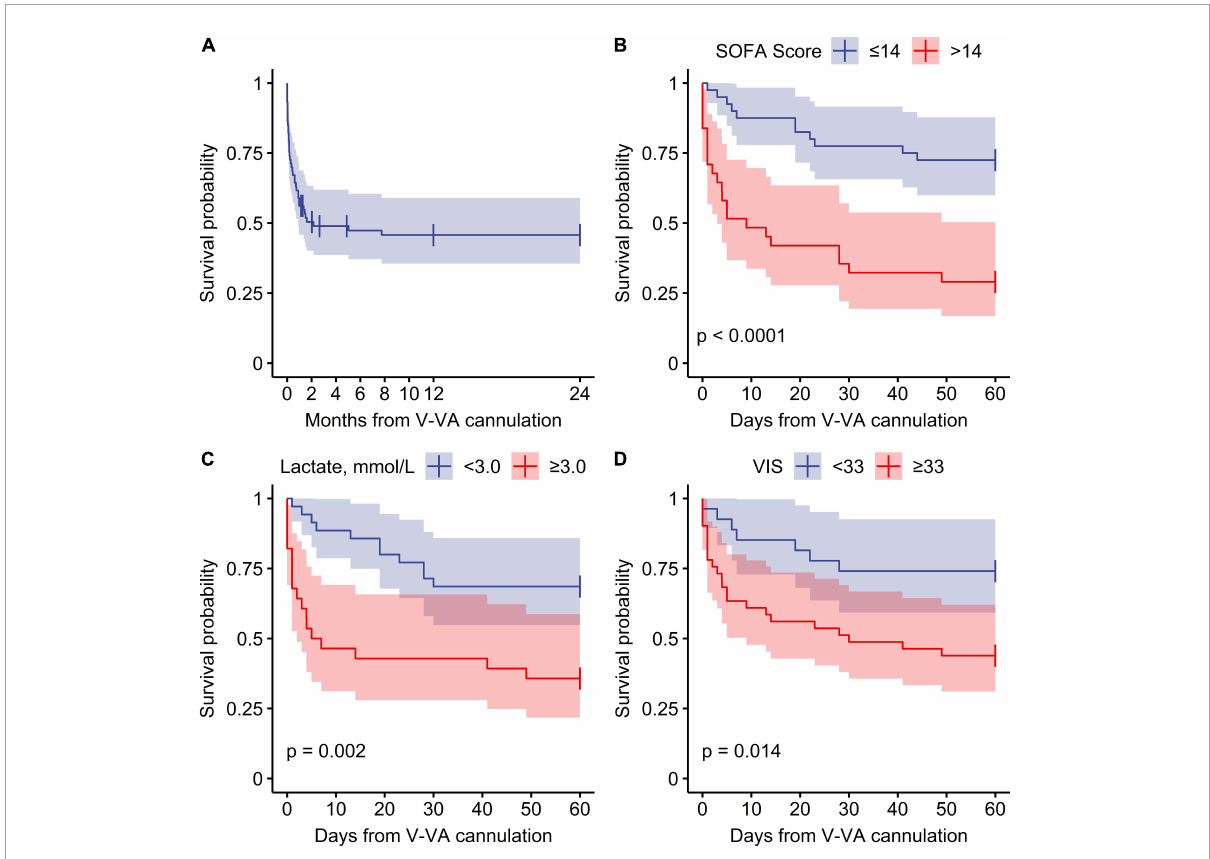
FIGURE3 Survival function from veno-venoarterial ECMO cannulation. (A) Overall survival, (B–D) stratified survival function for 60-day ICU mortality. SOFA, Sequential Organ Failure Assessment; VIS, Vasoactive inotropic